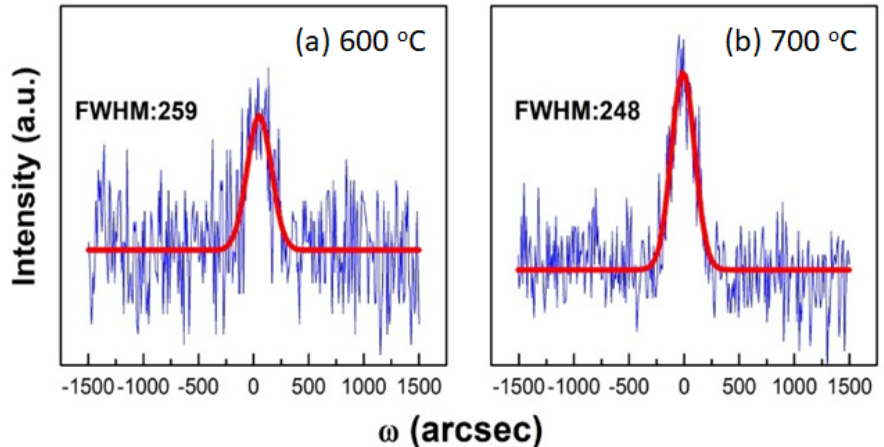
Figure 7. Rocking curve profiles and their fitting from HRXRD GaN (0002) at growth temperatures: ( a ) T2: 600 °C and ( b ) T3: 700 °C.